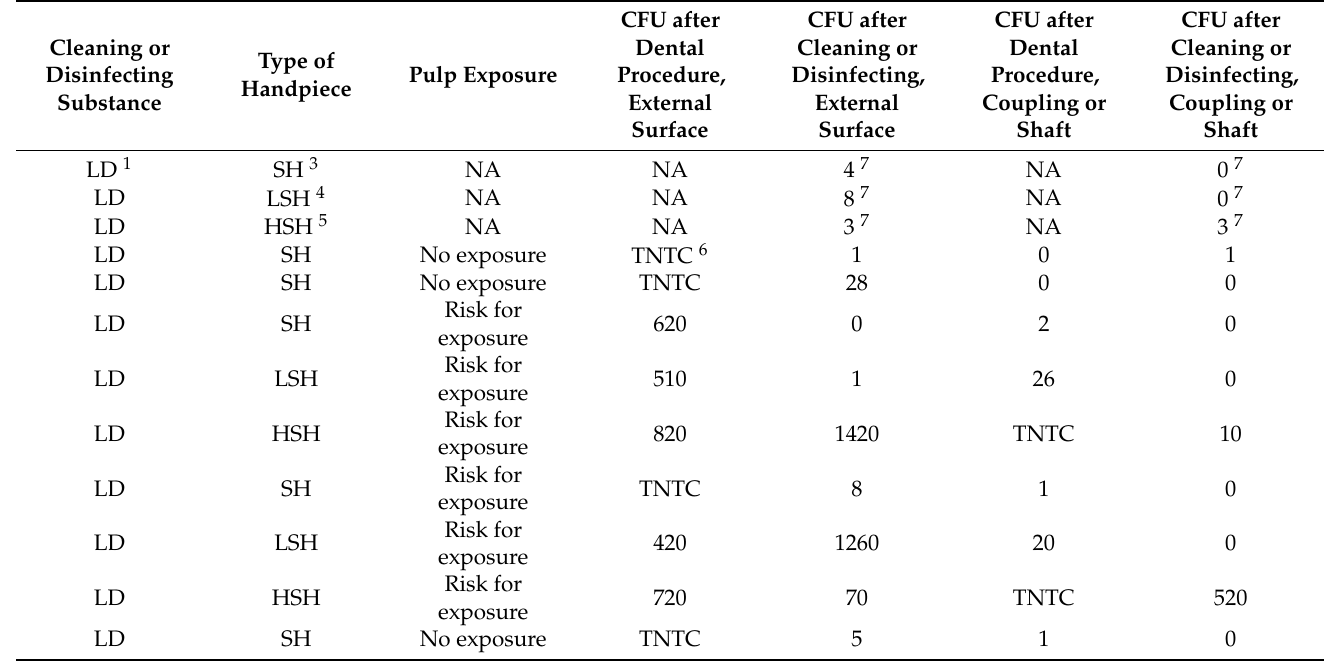
Table 4. Bacterial load of external surfaces, couplings, and the shaft of handpieces after dental procedures and after cleaning or disinfecting. Colony forming units (CFU) is given in total CFU/external surface, CFU/coupling and inner piece, respectively. Pulp exposure is divided into the categories: no exposure, risk for exposure, exposure, and not applicable. The difference between risk for exposure and exposure is that risk for exposure includes dental procedures when the pulp exposure is unintended and exposure includes dental procedures when pulp exposure is